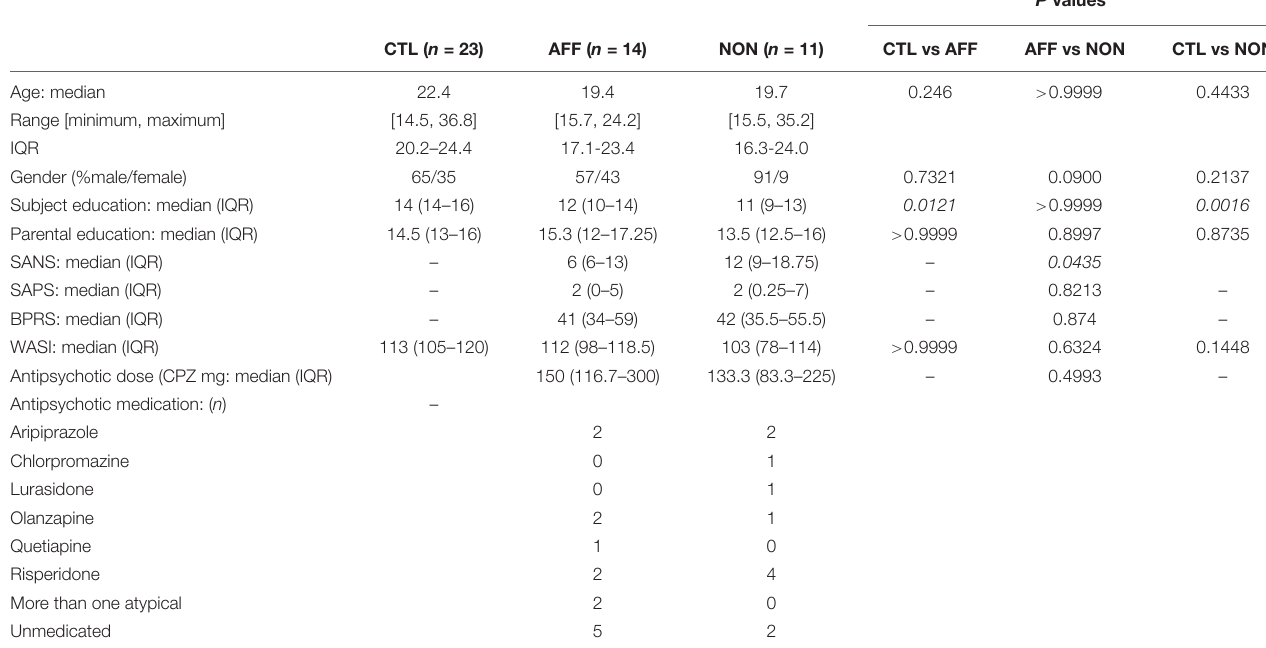
TABLE 1 | Demographic characteristics and clinical scores.